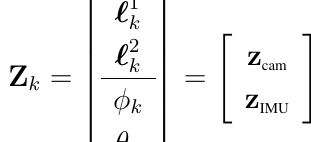
Figure 7. Projection model for a cylindrical object. W A, W B, W C, W D in the world frame with a planar imaging surface at a sample k . Although we actually measure different world points between frames, they are considered to be the same point due to the cylindrical nature of the object and the choice of line